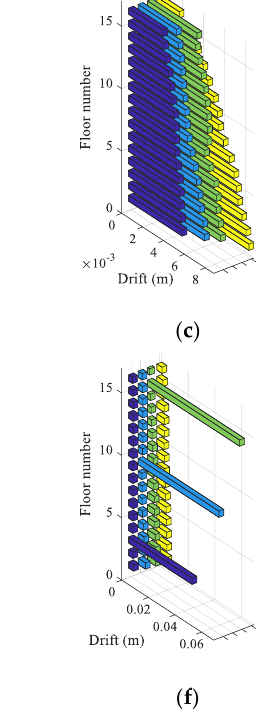
Figure 14. Story drift (El Centro): ( a ) left building of model 1; ( b ) left building of model 2; ( c ) left building of model 3; ( d ) right building of model 1; ( e ) right building of model 2; ( f ) right building of model 3.